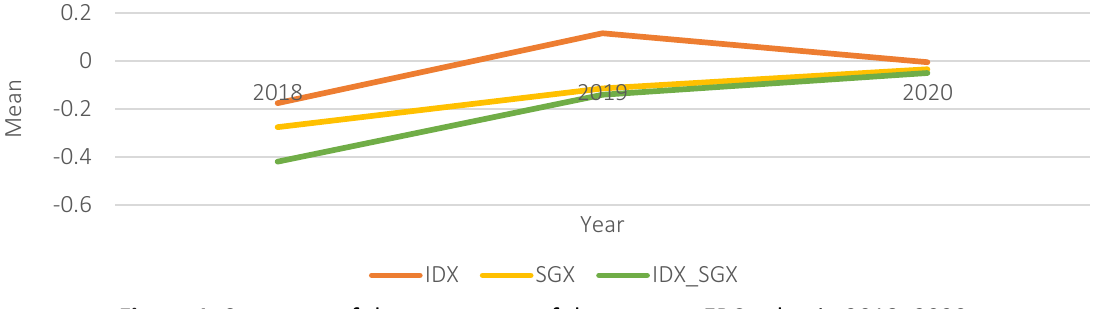
Figure 1. Summary of the movement of the average ERC value in 2018–2020